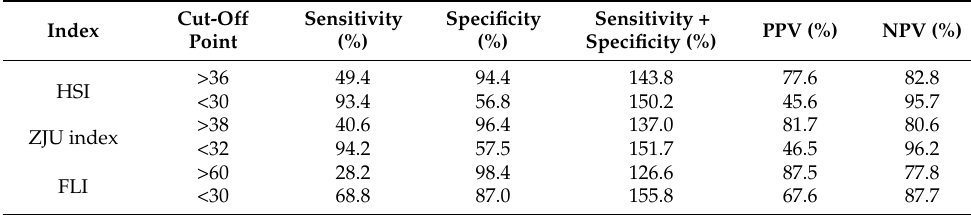
Table 2. Diagnostic accuracy of the HSI, ZJU index, and FLI.